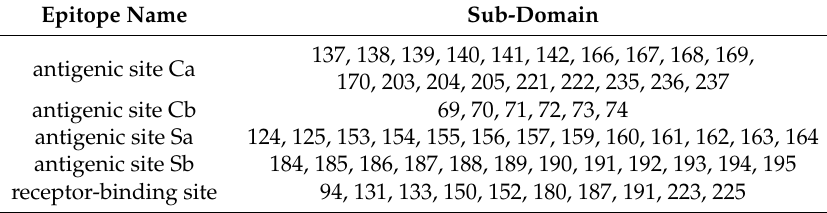
Table 1. Antigenic and primary sialic acid receptor-binding sub-domains in HA1, taken from